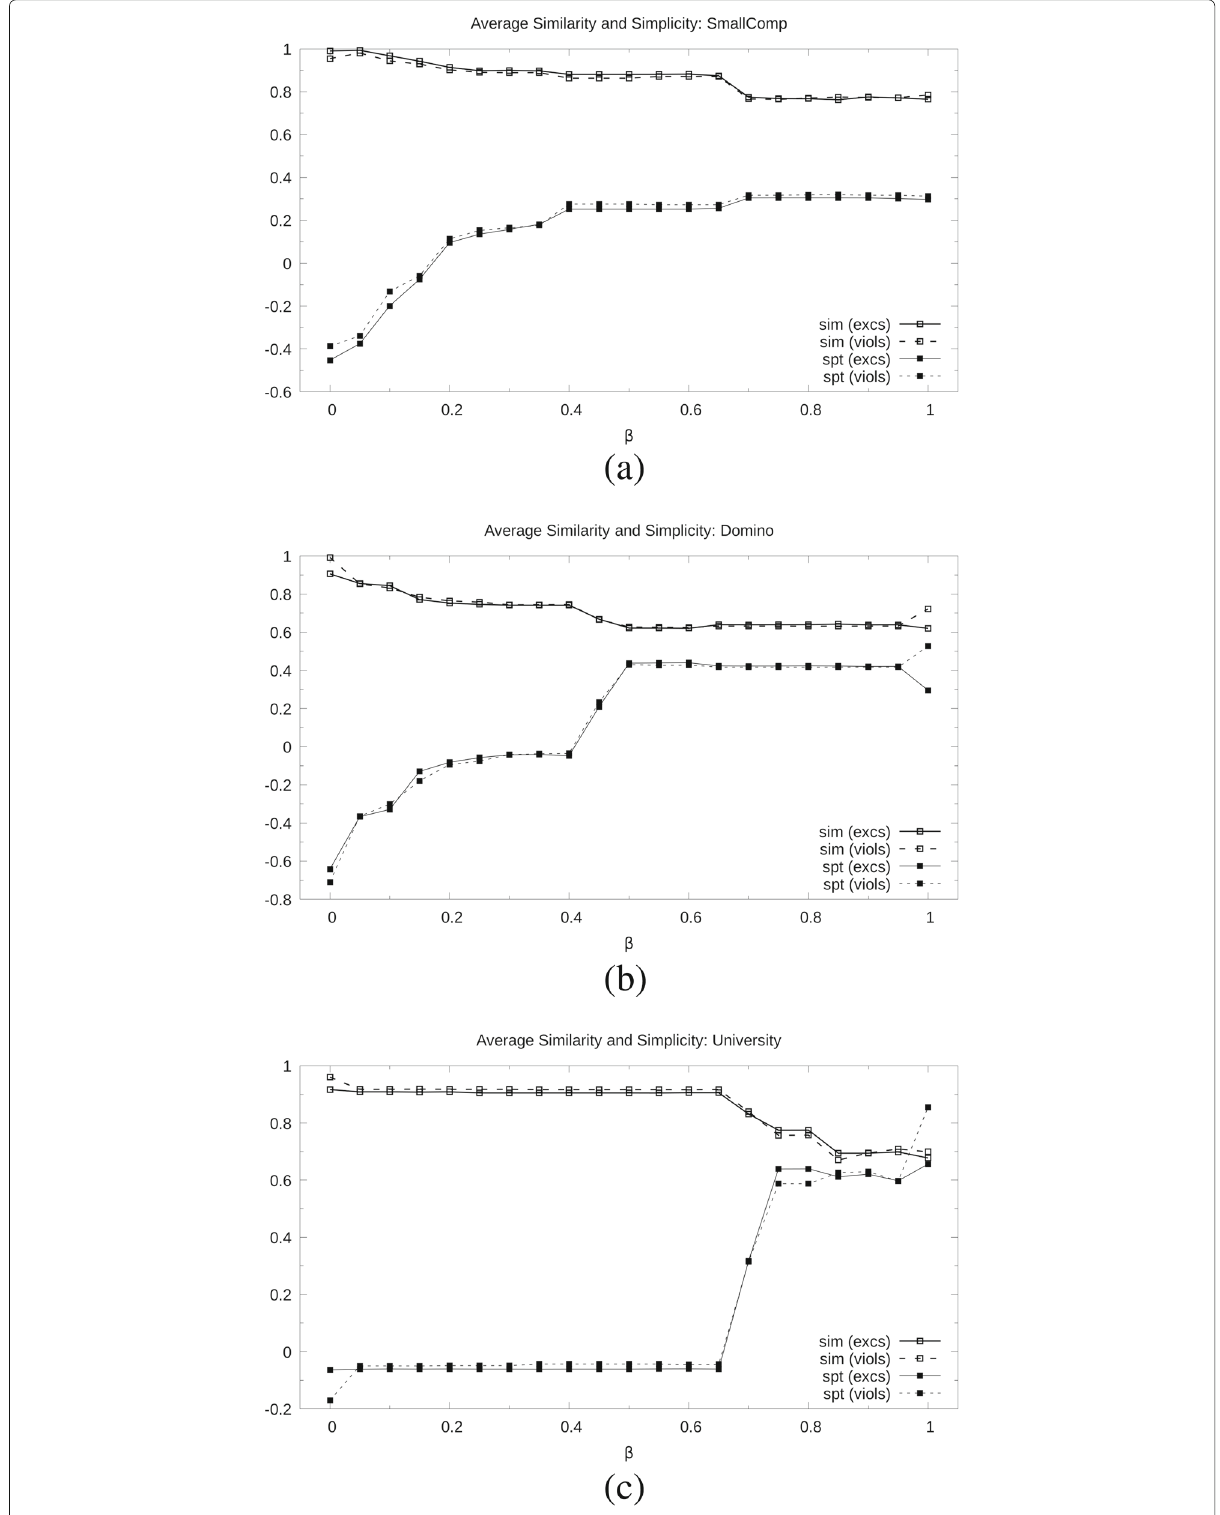
Fig. 4 Average similarity and simplicity ( y axis) as a function of the balance β ( x axis) for single exceptions and violations to ( a ) SmallComp , ( b ) Domino and ( c ) University dataset. Twenty-one values of β ∈ [0,1] are sampled, at regular intervals (step